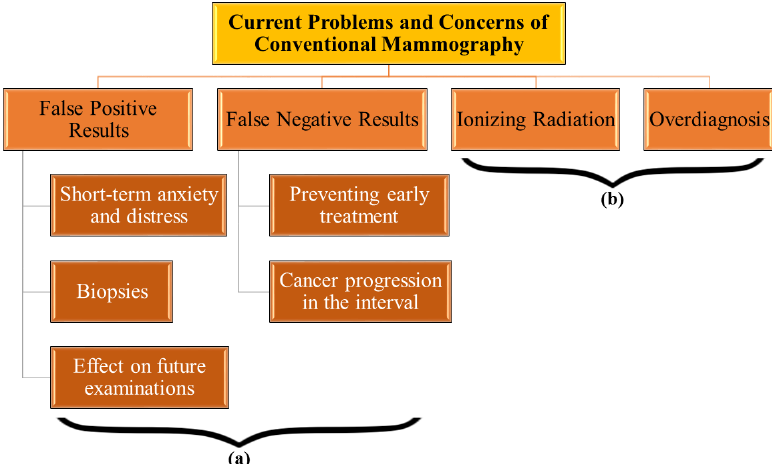
Figure 1. Current problems and concerns of mammography: ( a ) The problems that can be alleviated by the addition of a complementary imaging modality to mammography, ( b ) The concerns that are inherent to mammography and the addition of a complementary imaging system might not have a positive effect on